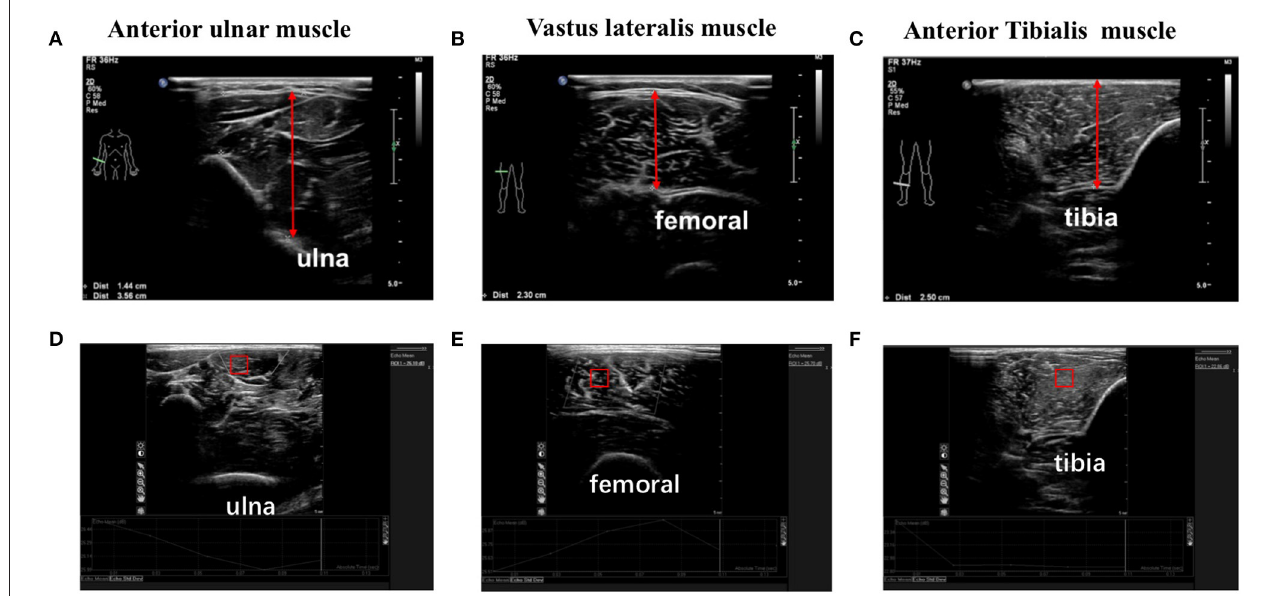
FIGURE 1 | The thickness and quality of anterior ulnar muscle, vastus lateralis muscle and anterior tibialis muscle were detected by ultrasound. (A–C) The thickness of anterior ulnar muscle, vastus lateralis muscle, and anterior tibialis muscle were detected by ultrasound; (D–F) The gray value of anterior ulnar muscle, vastus lateralis muscle and anterior tibialis muscle were analyzed by QLAB software to detect the muscle quality. Square sampling frame represents Region Of Interest (ROI).